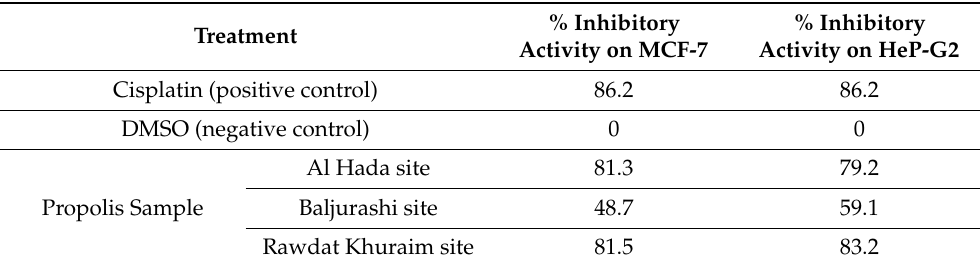
Figure 2. Inhibitory activity of the propolis samples against the human breast cancer (MCF-7) and human liver cancer cell lines (HeP-G2). Table 1. The cytotoxicity assay of the propolis sample on the human breast cancer (MCF-7) cell line and human liver cancer cell line